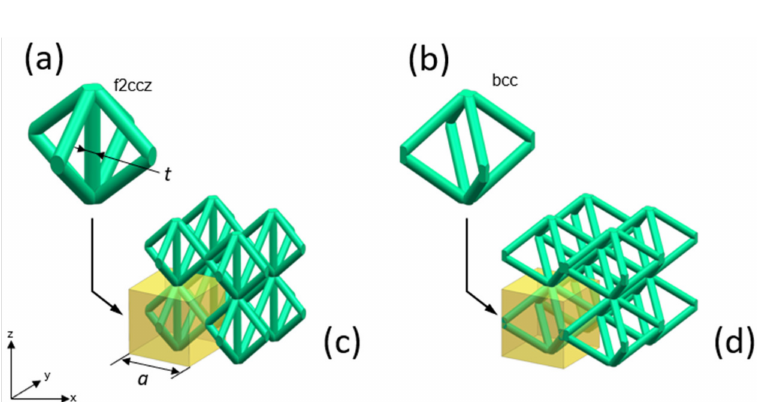
Figure 1. Considered unit cells and corresponding lattice structures. ( a ) f2ccz unit cell; ( b ) bcc unit cell; ( c ) f2ccz lattice structure; ( d ) bcc lattice